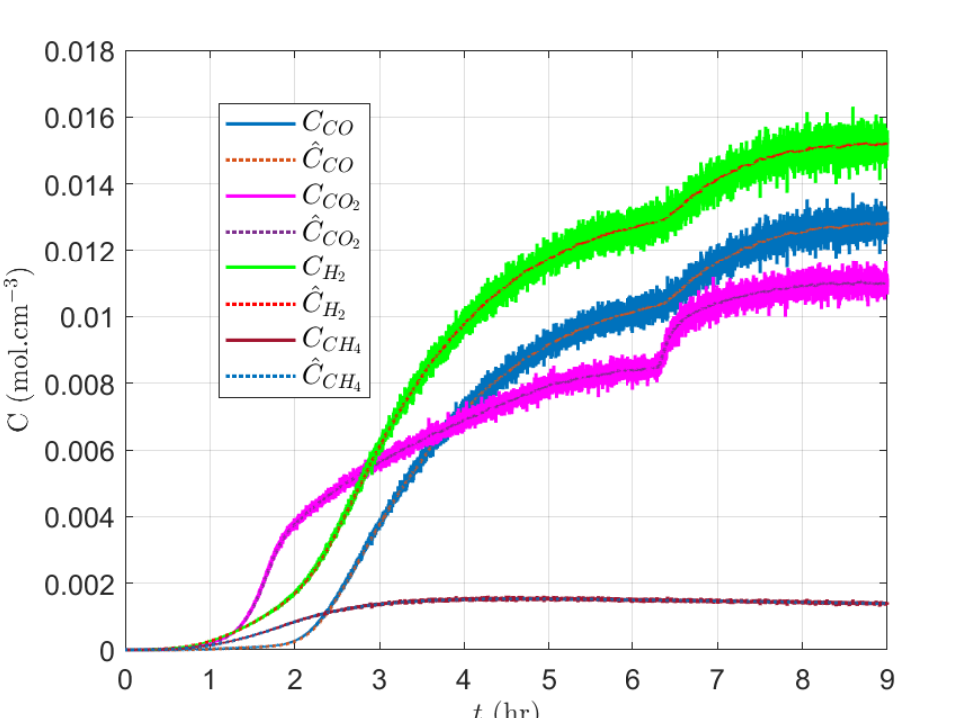
Figure 8. Measured and estimated concentrations of gases with